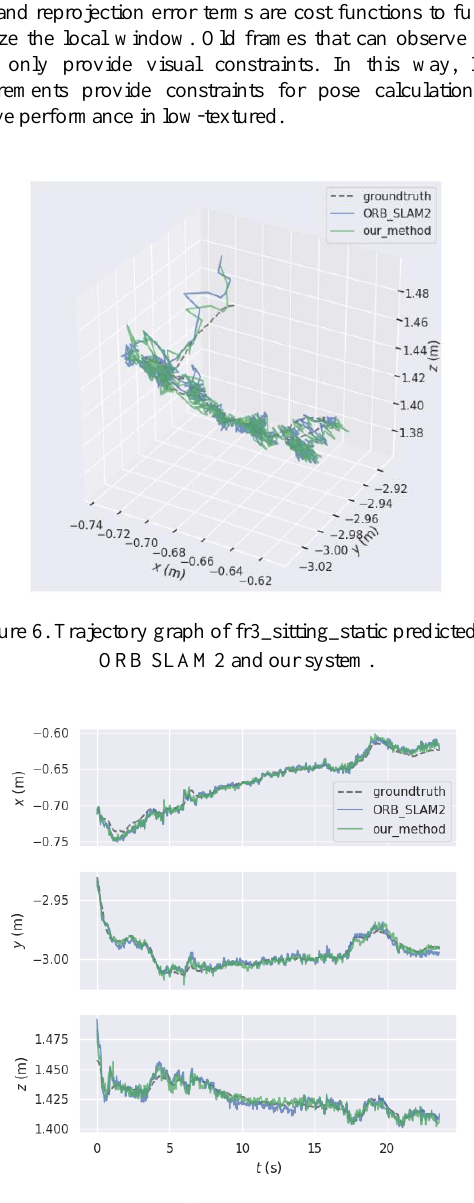
Figure 7. Trajectory of fr3_sitting_static projected in xyz direction